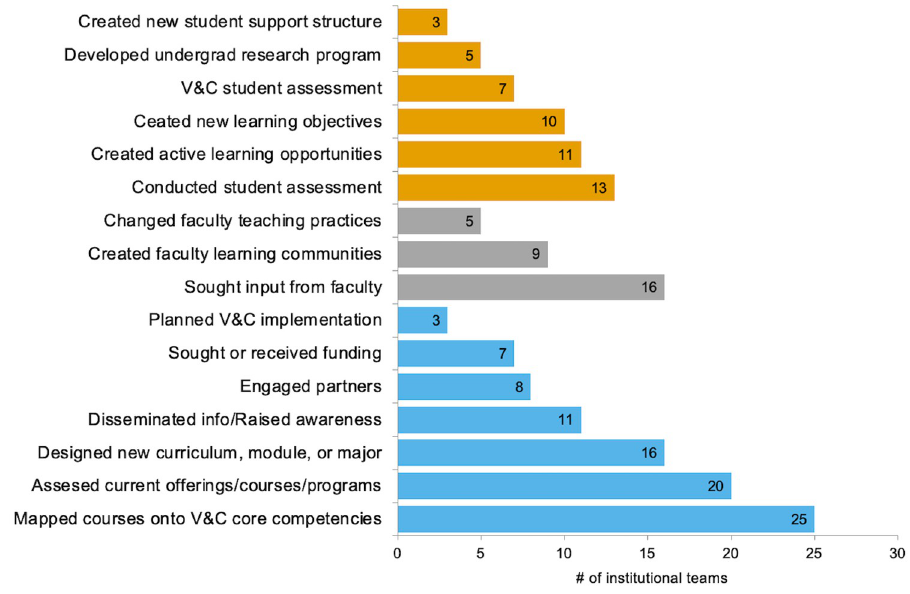
Fig 7. Analysis of progress-to-date posters presented by institutional teams from cohorts 1–3 at NW BIO (n = 42). Sixteen actions at three levels of influence: student (orange), faculty (grey), and department/institution (blue) were identified by two or more institutional teams.